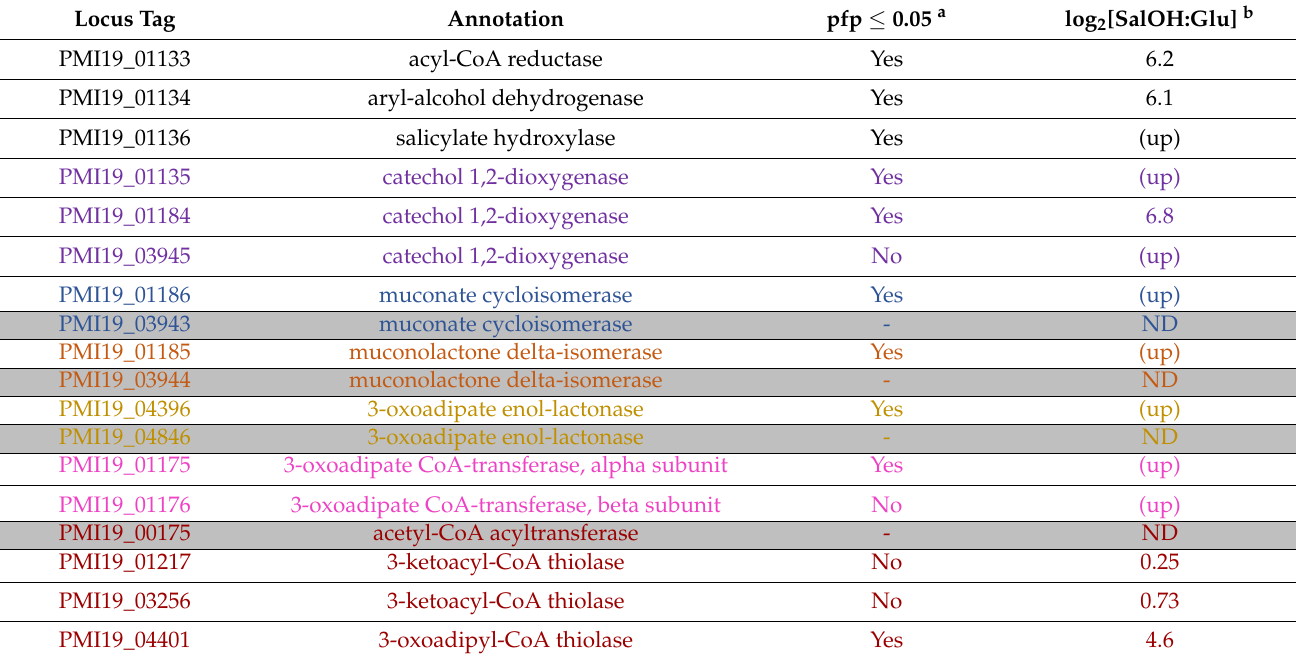
Table 1. Proteins in a probable pathway of salicyl alcohol degradation were significantly upregulated in the proteome of P. fluorescens GM16 when grown on salicyl alcohol versus growth on glucose. Locus Tag